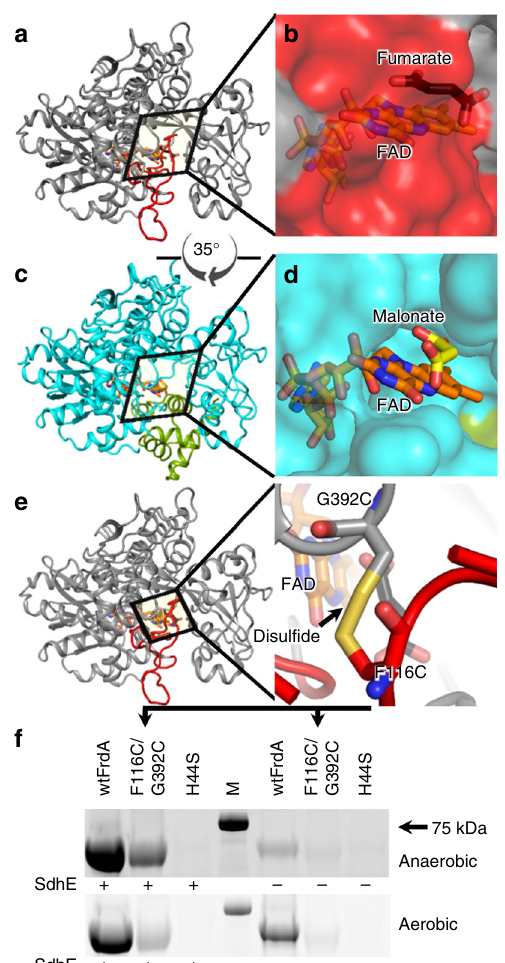
Fig. 2 Active site tunnel in the FrdA-SdhE assembly intermediate. a The FrdA subunit within the context of the assembled FrdABCD complex (PDB entry 3P4P 21 ). Residues 50 – 58 and 103 – 129 are highlighted in red. b Surface representation of the FrdA subunit within the context of assembled FrdABCD. The surface contributed by the loops (50 – 58 and 103 – 129) is shown in red. c The FrdA-SdhE assembly intermediate lacks interpretable electron density for residues 50 – 58 and 103 – 129. d Surface representation of the FrdA-SdhE assembly intermediate lacking these